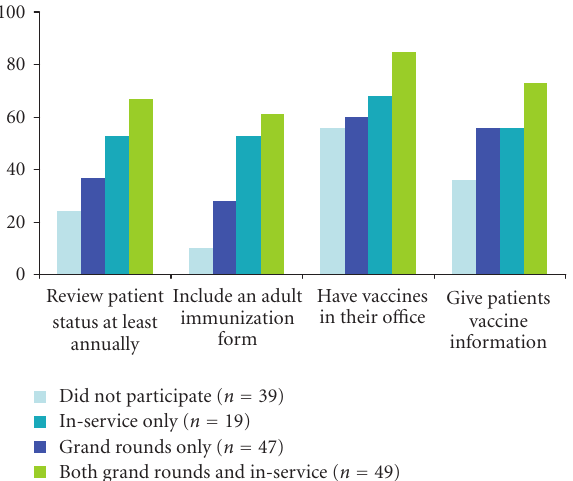
Figure 1: Interventions, participation, and o ffi ce practice. Gyne- cologists who attended in-service or grand rounds educational lec- tures were more likely to vaccinate or provide vaccine information to their patients than those who did not